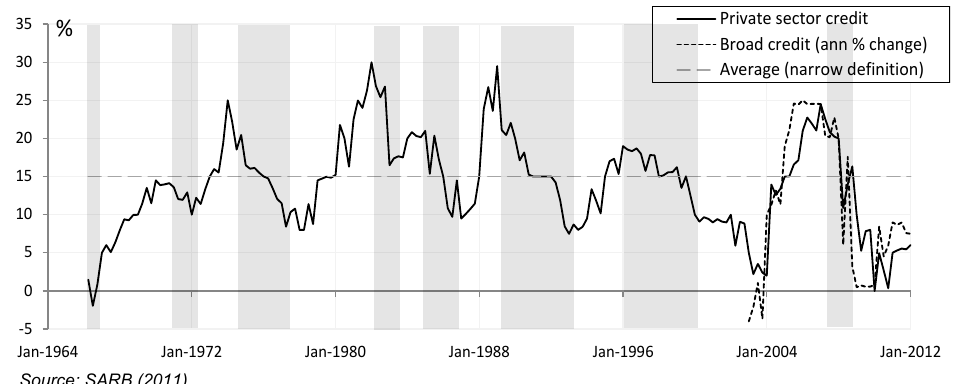
Growth in broad and narrow credit in South Africa from 1966 to